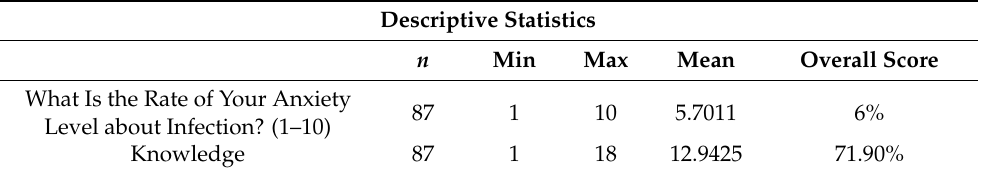
Table 3. Level of knowledge and anxiety of participants ( n = 87).